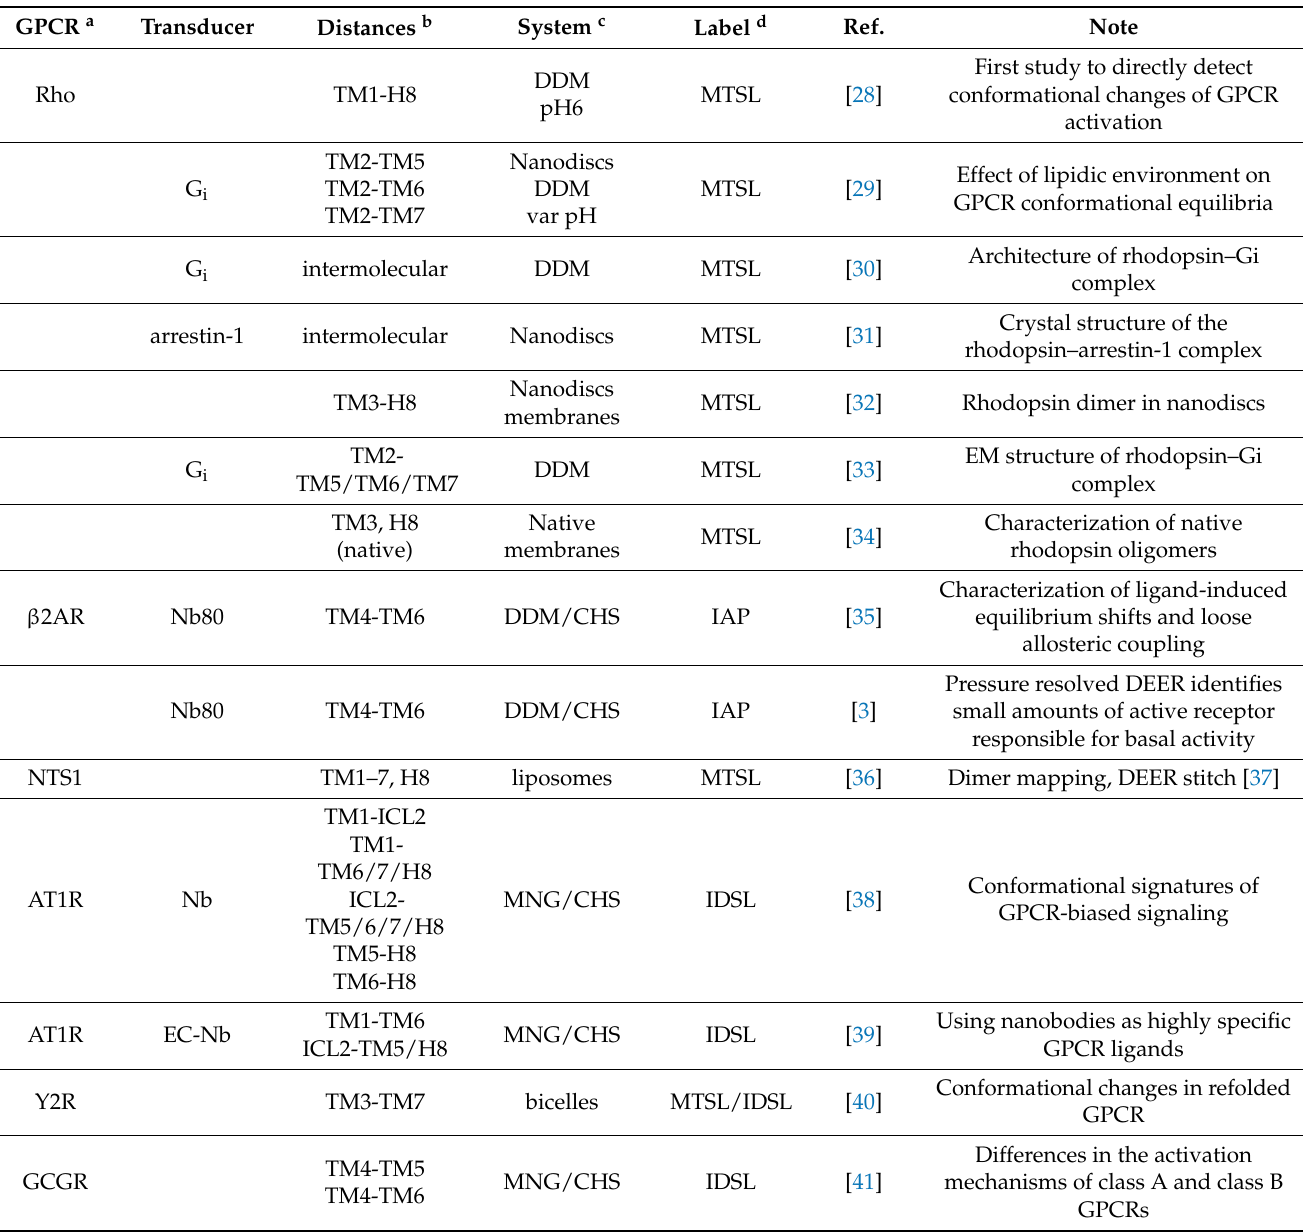
Table 1. Published DEER